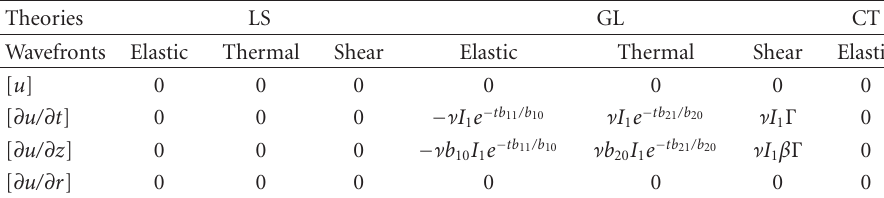
Table 4.2. Propagating discontinuities in u and its first derivatives, where Γ = − 2( b 20 − b 10 ) /β , I 1 = 1 /